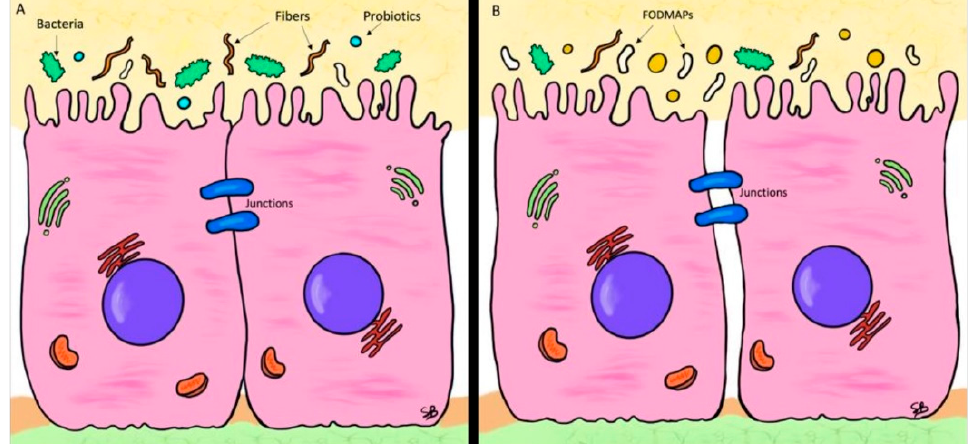
Figure 1. Normal vs. leaky gut ( A ) Normal enterocytes characteristic of a healthy gut. Thanks to the barrier balance, due to microbiota, fibers and pre ‐ and pro ‐ biotics, the TJs are intact and IP is preserved; ( B ) Typical epithelium of a leaky gut. TJs are malfunctioning due to an excess of FODMAPs, dysbiosis and scarcity of fibers and pre ‐ and pro ‐ biotics.